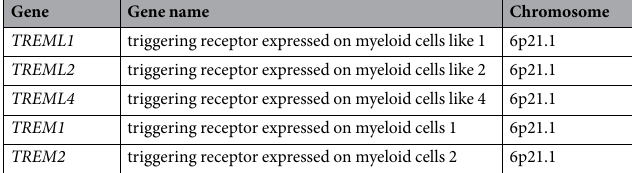
Table 1. TREM family of genes.